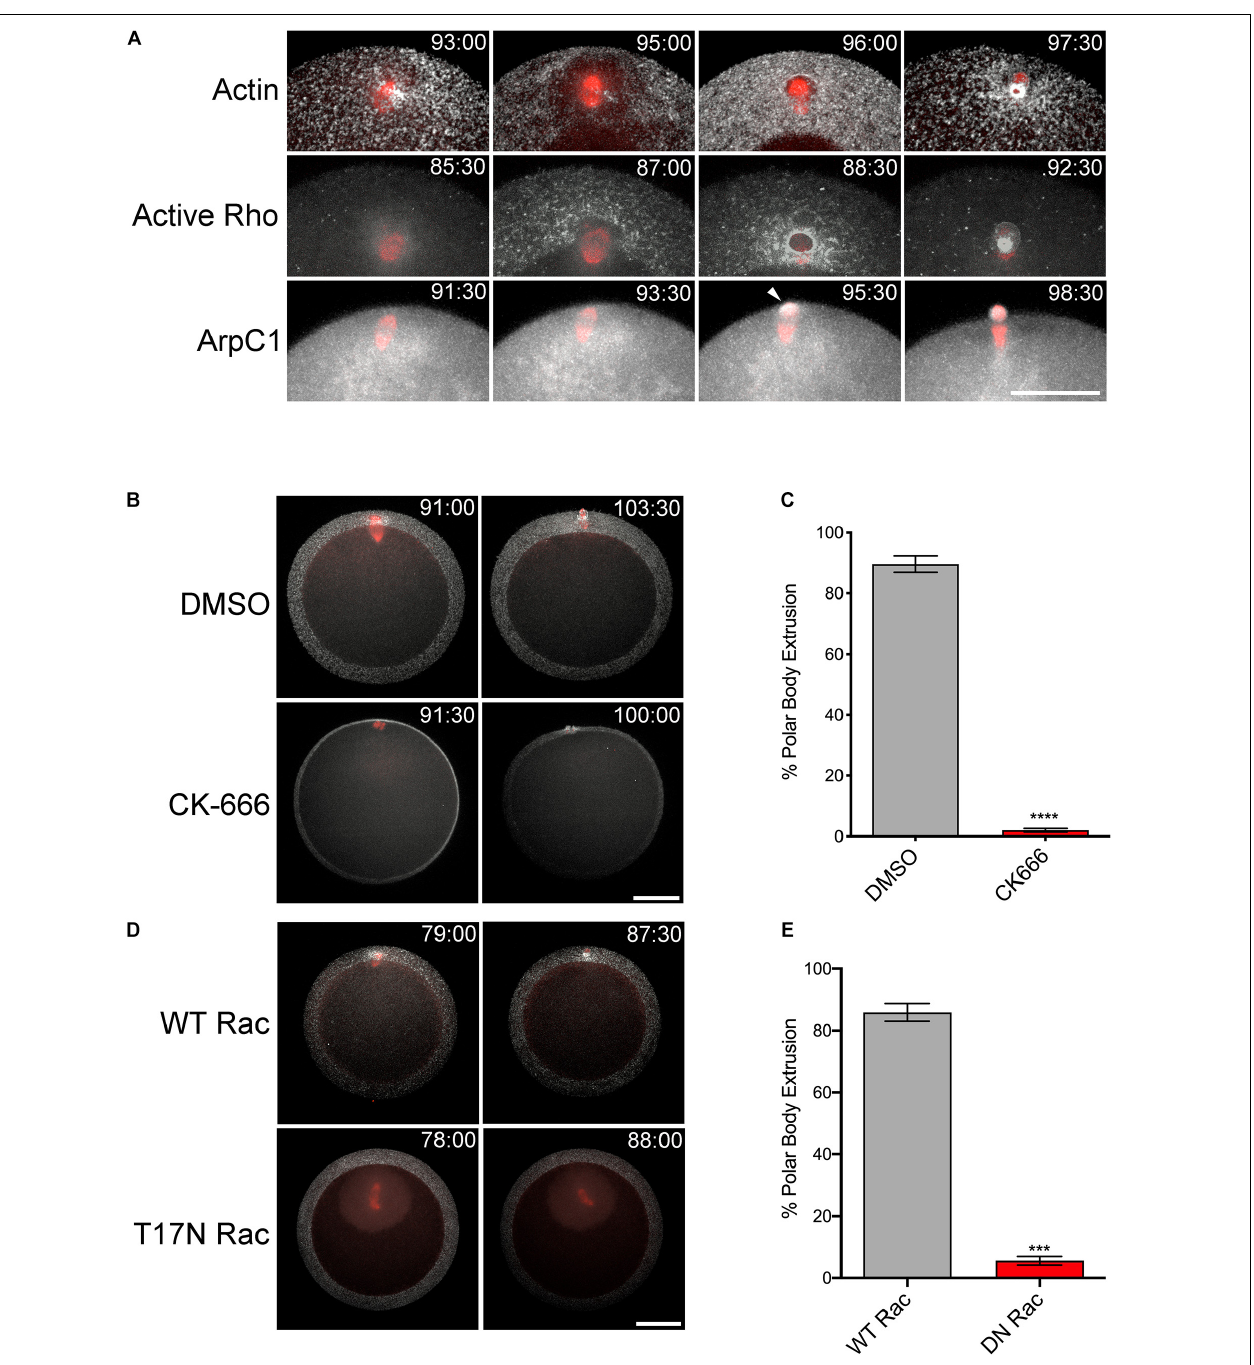
FIGURE 4 | Rac and Arp2/3 are required for polar body extrusion in sea star oocytes. (A) First polar body extrusion in P. miniata oocytes co-expressing Lifeact (white) and GFP-tubulin (red), rGBD-GFP (white) and mCherry-EMTB (red), and ArpC-GFP (white) and mCherry-EMTB (red). Time points indicate minutes post-hormone activation. Arrow denotes protruding polar body. Bar, 50 µ m. (B) P. miniata oocytes co-expressing Lifeact (white) and GFP-tubulin (red) were activated with maturation hormone and 40 min following germinal vesicle breakdown, were treated with 0.1% DMSO or 100 µ M CK-666. The spindle in the CK-666 sample is positioned in the Z axis of the image. The spindle failed to rotate or form a polar body protrusion. Bar, 50 µ m (C) Quantification of polar body formation in DMSO or CK-666 samples for three experimental replicates, 100 oocytes scored per condition per experiment (Mean ± SEM, **** p < 0.0001). (D) P. miniata oocytes co-expressing Lifeact (white), GFP-tubulin (red) and either wild-type (WT) or dominant-negative (T17N) Rac. In contrast to WT Rac-injected oocytes, T17N Rac-expressing oocytes failed in polar body formation after spindles failed to dock at the cortex. Bar, 50 µ m. (E) Quantification of polar body formation in WT or T17N Rac-expressing oocytes for three experimental replicates, 100 oocytes scored per condition per experiment (Mean ± SEM, *** p < 0.001).